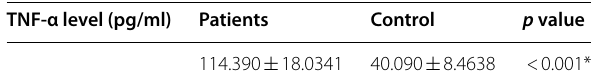
Table 2 Comparison between TNF α serum level between the two groups